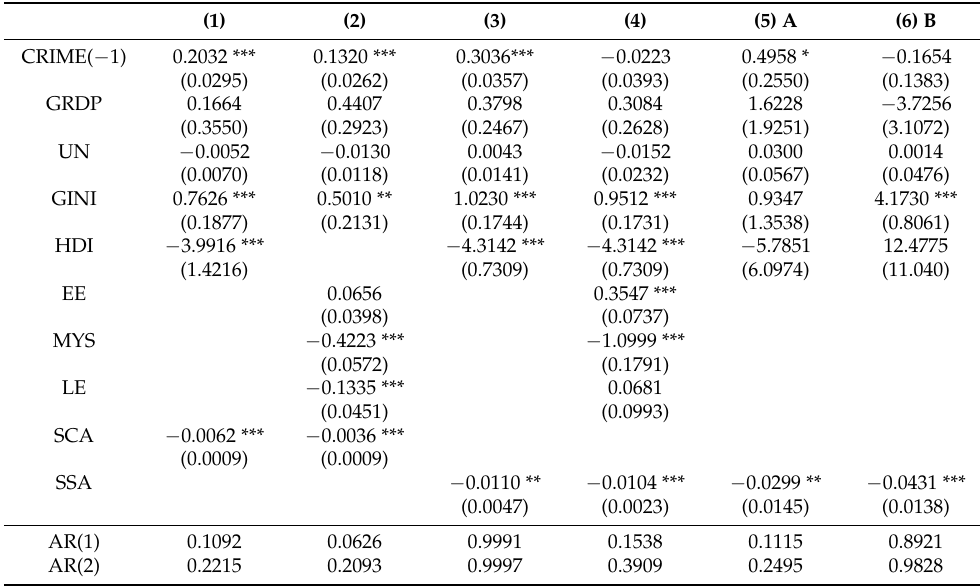
Table 5. Estimation results for settlement of criminal acts and spending on social